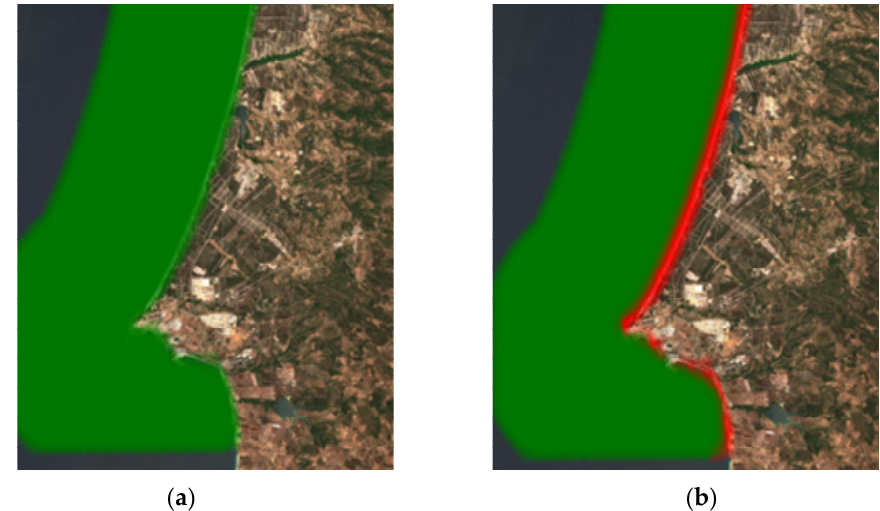
Figure 14. ( a ) Neural Network Prediction; ( b ) final decision considering land use data.